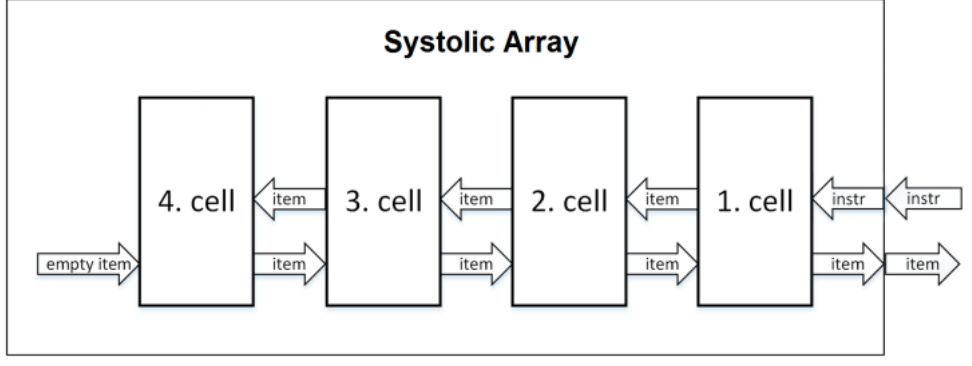
Figure 2. Systolic Array architecture example [41,42,49,50].